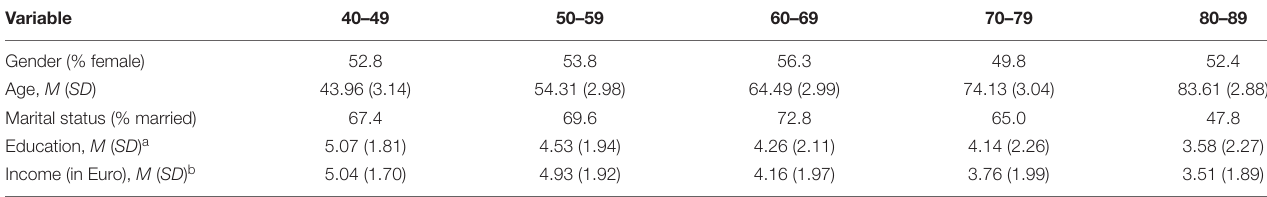
TABLE 1 | Sociodemographic information for the full